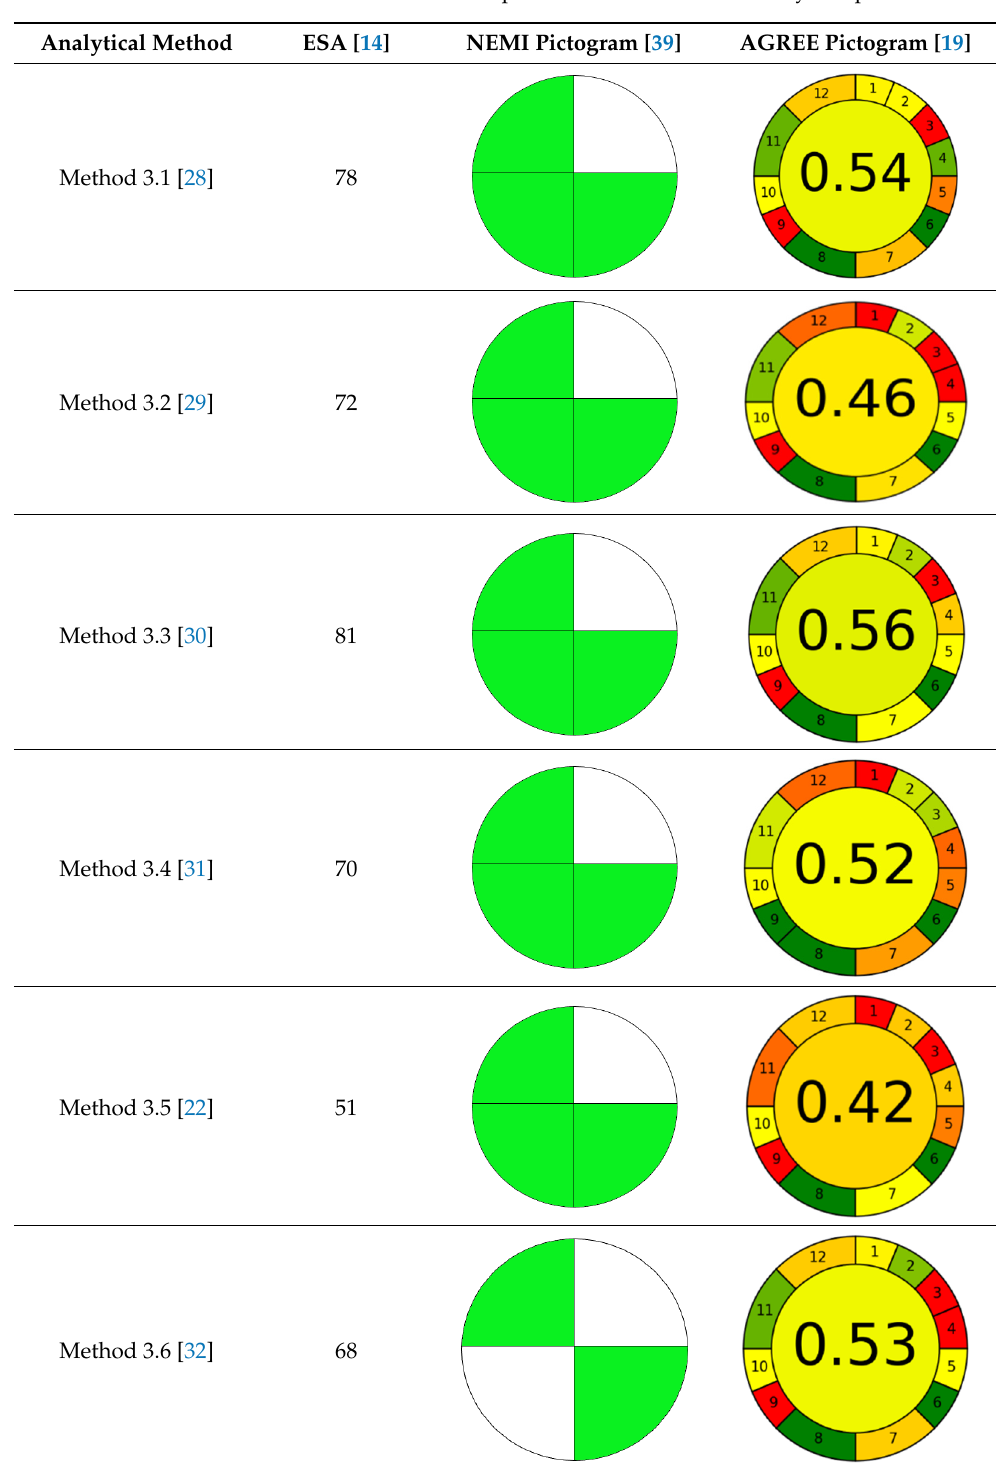
Table 3. Greenness assessment results of methamphetamine and tramadol analytical procedures.